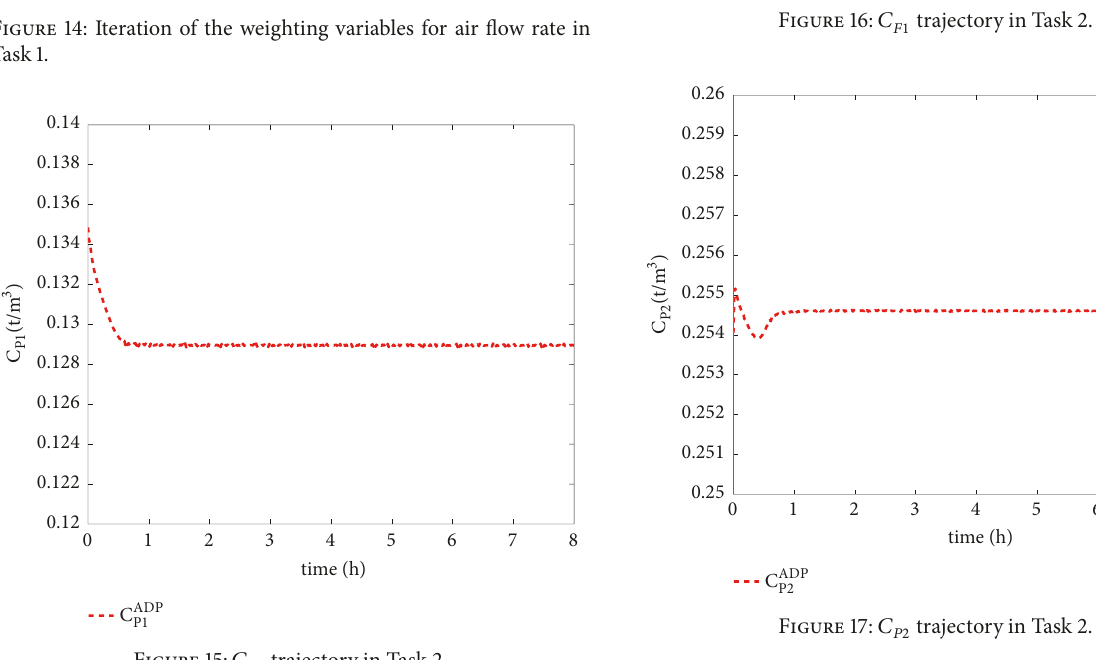
Figure 15: 𝐶 𝑃1 trajectory in Task 2.